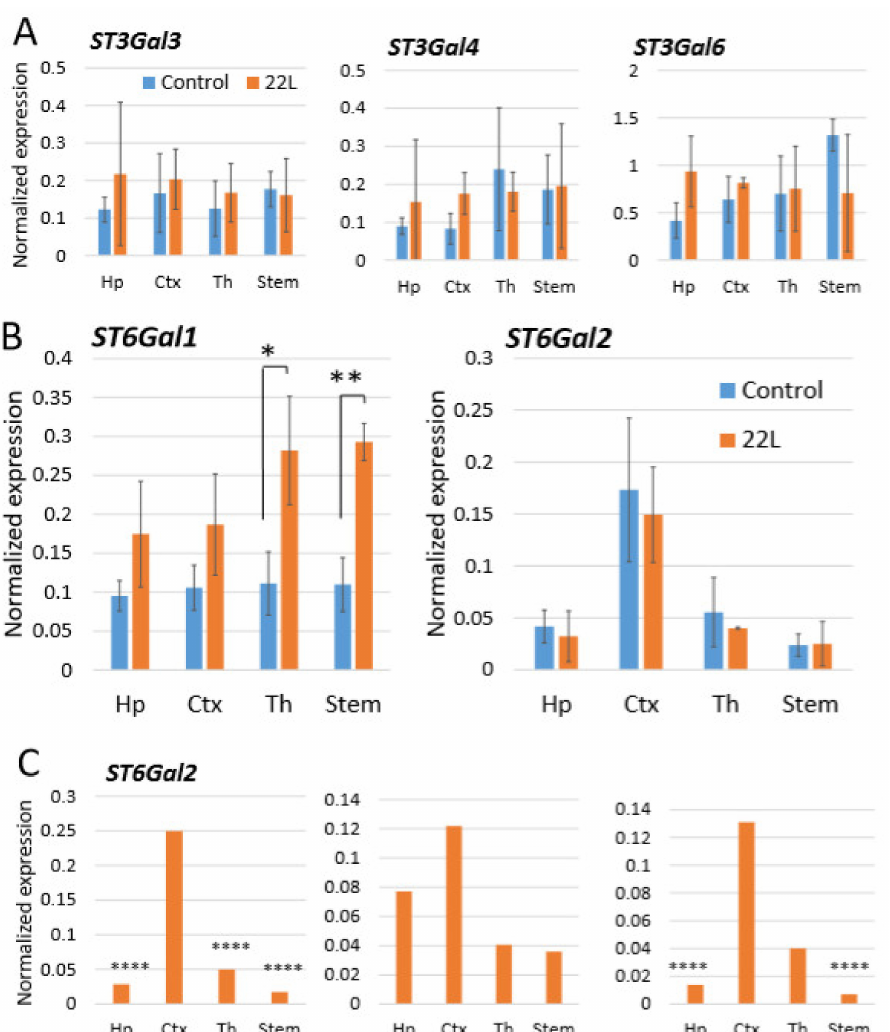
Figure 5. Analysis of gene expression by qRT-PCR. Expression of ST3Gal3, ST3Gal4 and ST3Gal6 ( A ), and ST6Gal1 and ST6Gal2 ( B ) in hippocampus (Hp), cortex (Ctx), thalamus (Th) and stem of 22L-infected animals or normal age-matched controls normalized by the expression of housekeeping gene TBP . The mean and standard deviation are shown ( n = 3 animals). ( C ) Expression of ST6Gal2 in hippocampus (Hp), cortex (Ctx), thalamus (Th) and stem of three individual 22L-infected animals normalized by the expression of housekeeping gene TBP . Statistical significance between the groups in ( A ) and ( B ) was calculated by Student’s unpaired t-test and indicated as * for p < 0.05 and ** for p < 0.01; in ( C ), **** indicates p < 0.0001 significance of di ff erences (threshold regulation = 4) between samples analyzed in triplicate, and was calculated by BioRad CFX